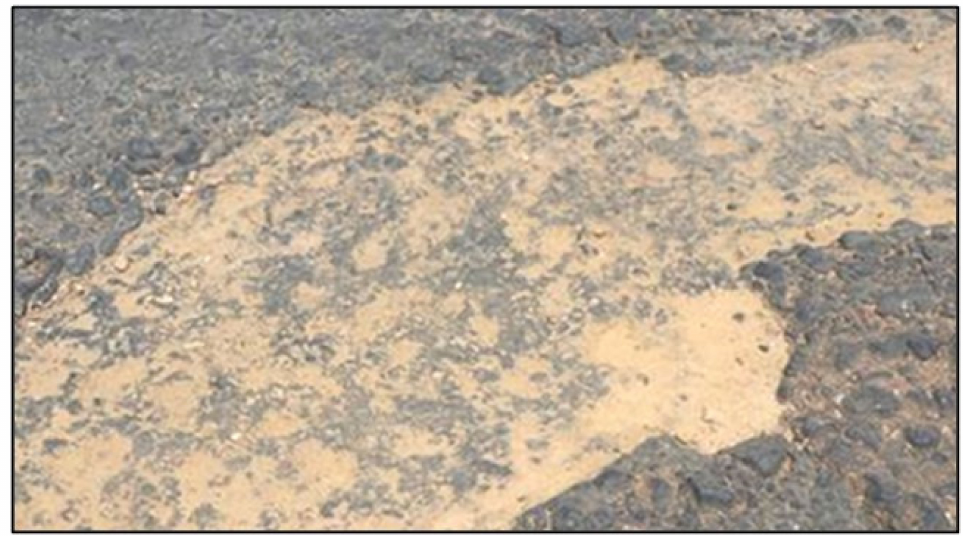
Figure 24. Stripping of surfacing (double seal with an elastomer modified binder) due to a contami- nated binder (December 2018), resulting in little damage to an exposed NME stabilised base-layer after 2 months of traffic in the rainy season (in situ material originally of quality CBR > 10 @ 93% mod AASHTO) (Gauteng Province, South